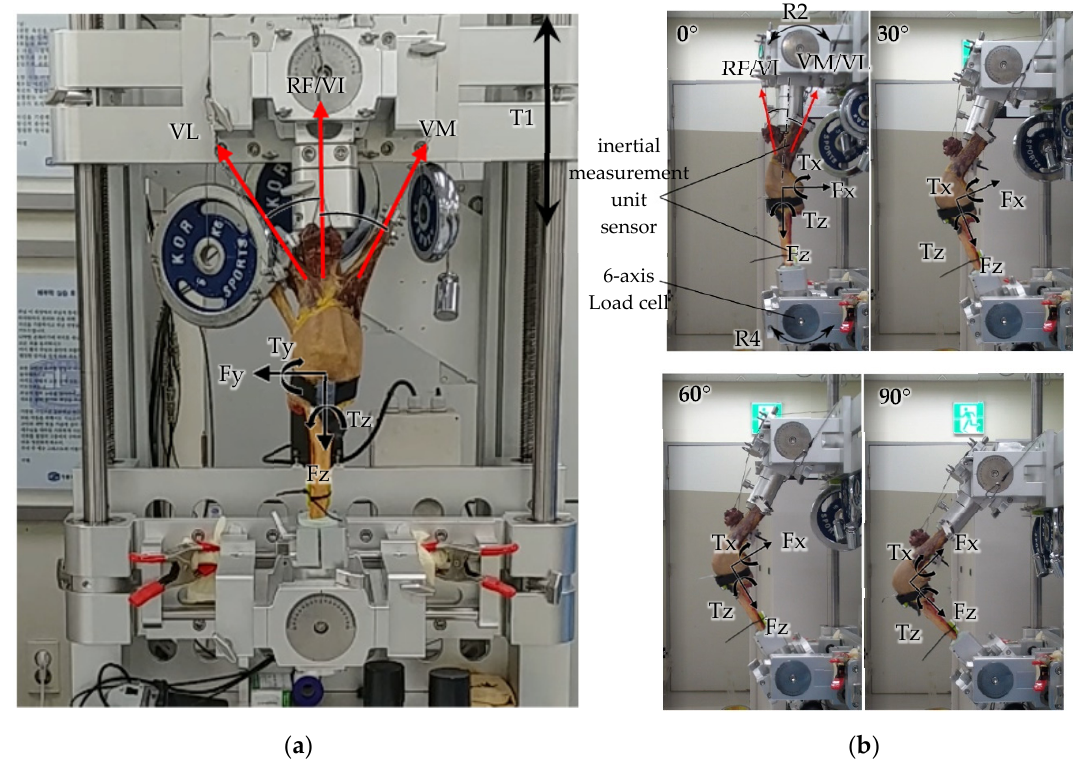
simulator system.